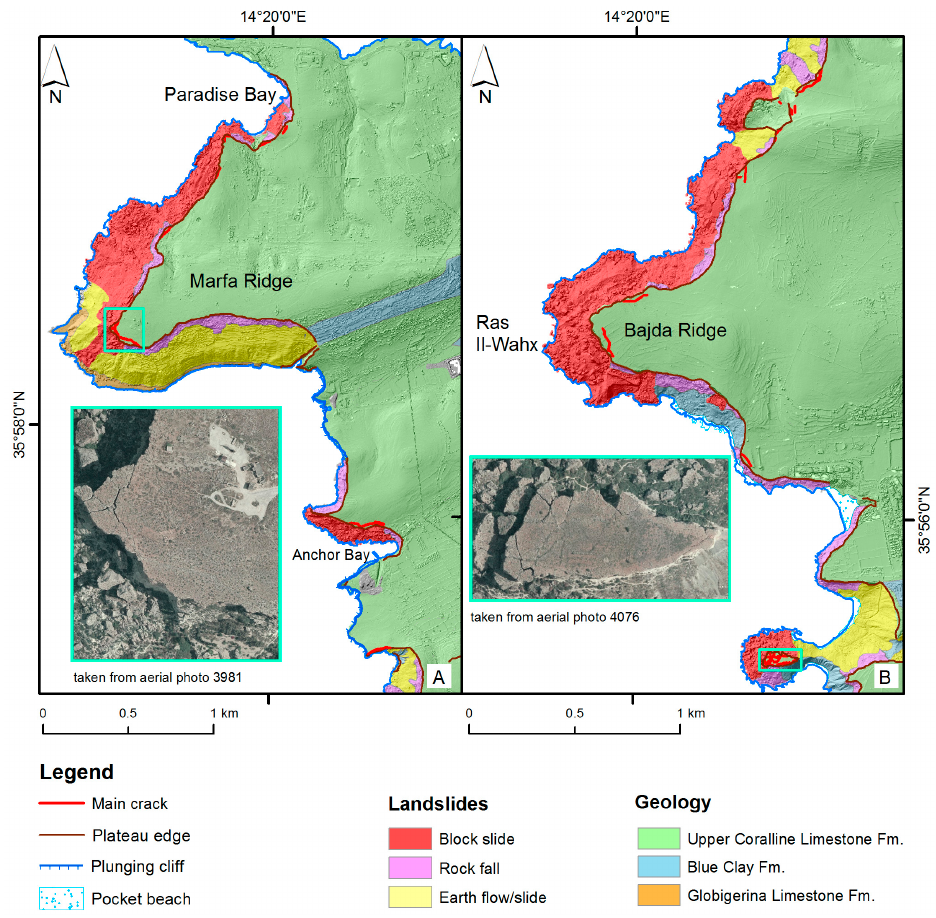
Figure 2. Distributions of the main cracks affecting the plateaus. ( A ) Detail of the northernmost part of the study area; ( B ) detail of the southernmost part of the study area.